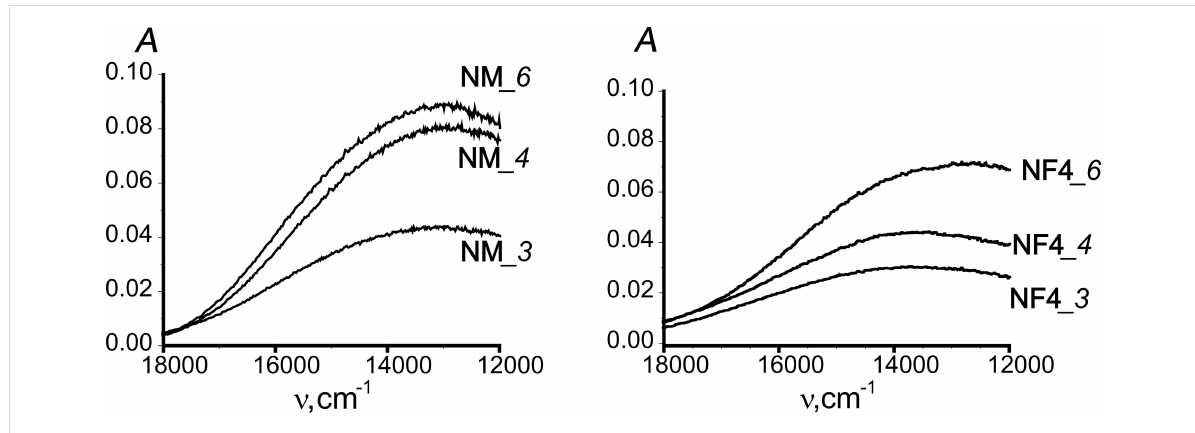
(Table S6, Supporting Information File 1). For bifunctional samples, especially those containing fluoroalkyl radicals, the gross compositions of Cu 2+ /Lig complexes are close to 1:1.